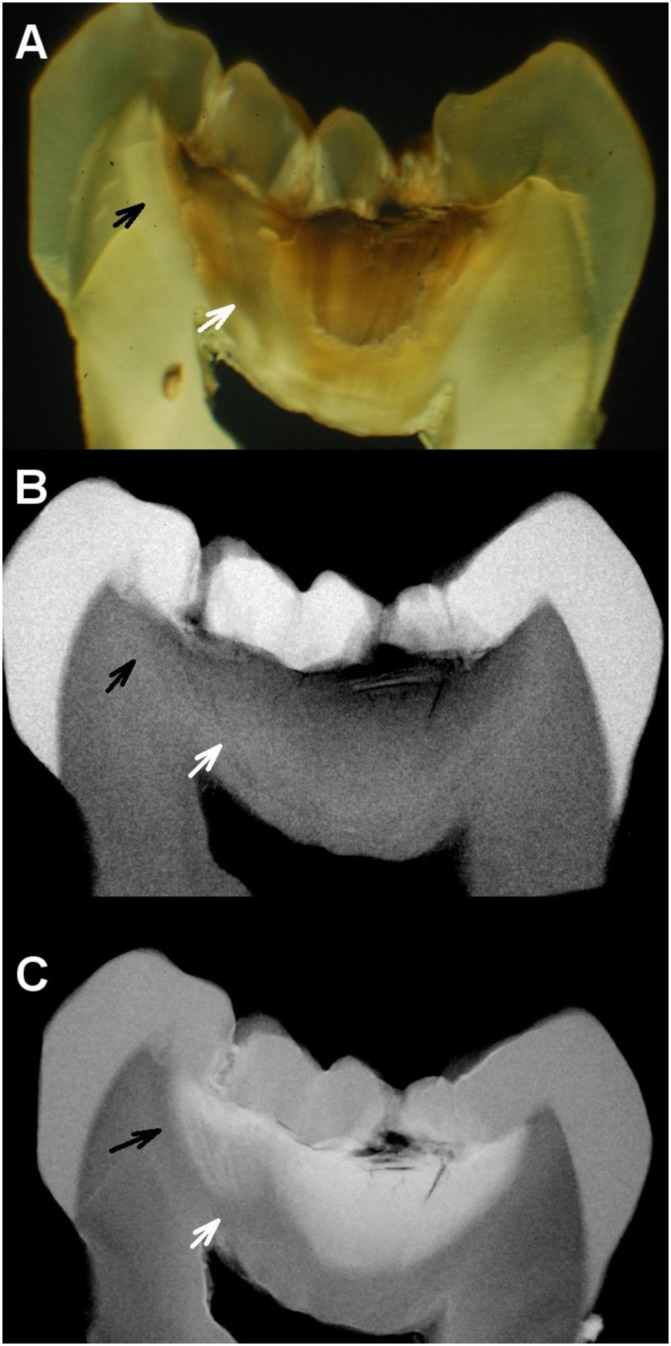
Histology of ICDAS score 4.Internal histological features of an occlusal surface with ICDAS score 4 visualized under SM (A), microradiography without contrast (B), and MRC (C), with similar lesion depth in all techniques. The contrast solution infiltrated demineralized dentin following the paths of the dentinal tubules. Both sites pointed by the black and white arrows have the same aspect (dentin sclerosis) under both microradiography without contrast (B) and MRC (C), but under SM those sites have different aspects: the site pointed by the black arrow has white opaque aspect, and the site pointed by the white arrow has a translucent aspect (A).